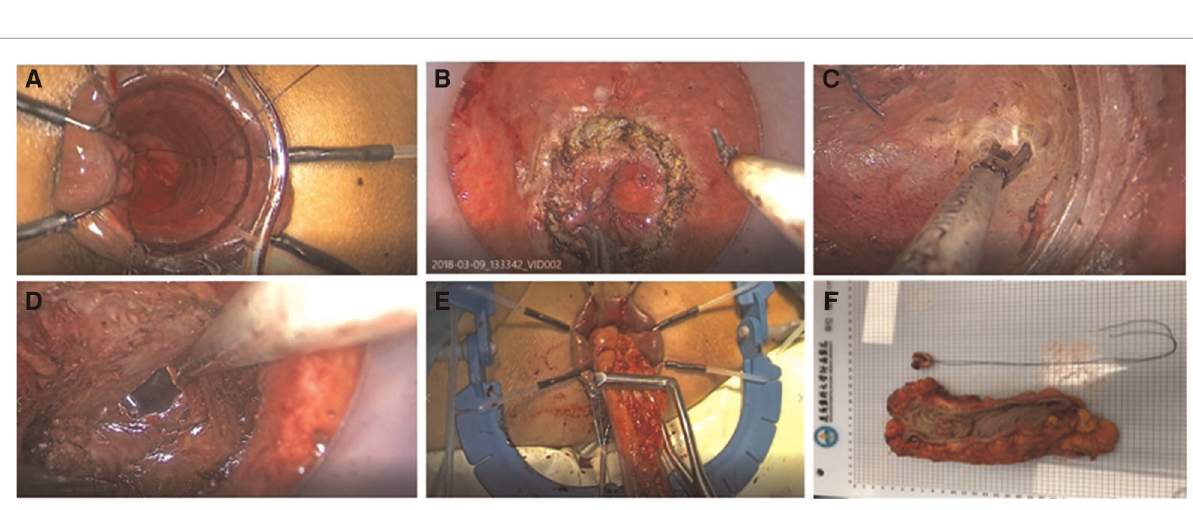
FIGURE 2 ( A ) Closure of intestinal cavity with purse-string suture ( B ) Layer-by-layer dissection of the entire rectum at a predetermined location ( C ) Bottom-up separation of the rectal mesentery ( D ) Convergence of the transanal and transabdominal groups ( E ) Extraction of the proximal intestine and disconnection of the proximal sigmoid colon ( F ) Pathological